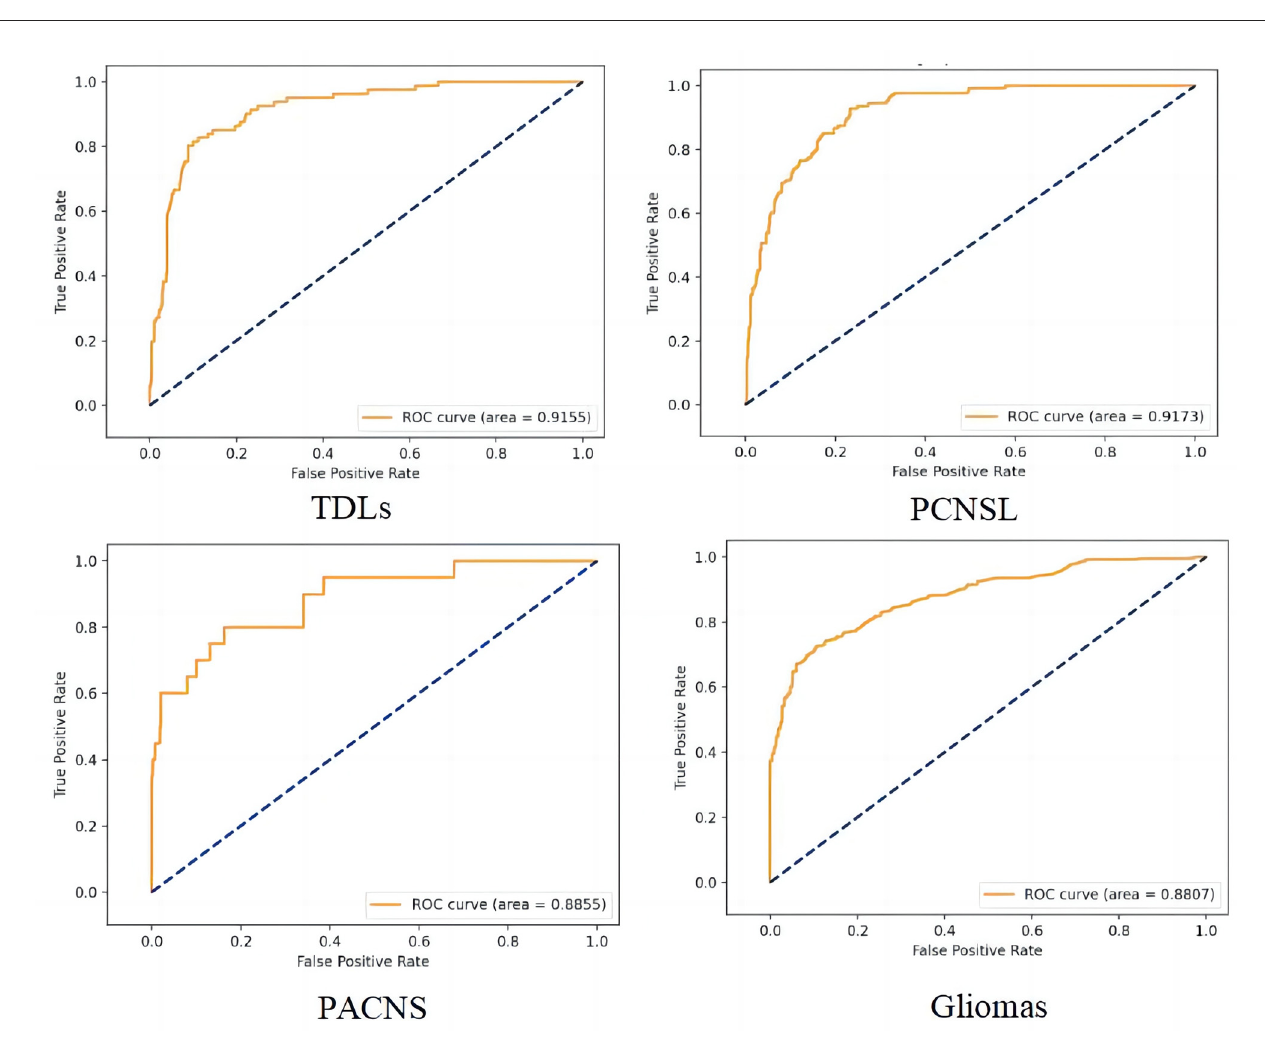
FIGURE4 The receiver operating characteristic (ROC) curve of the four different diseases. False positive rate (FPR) = 1-specificity, True positive rate (TPR) =